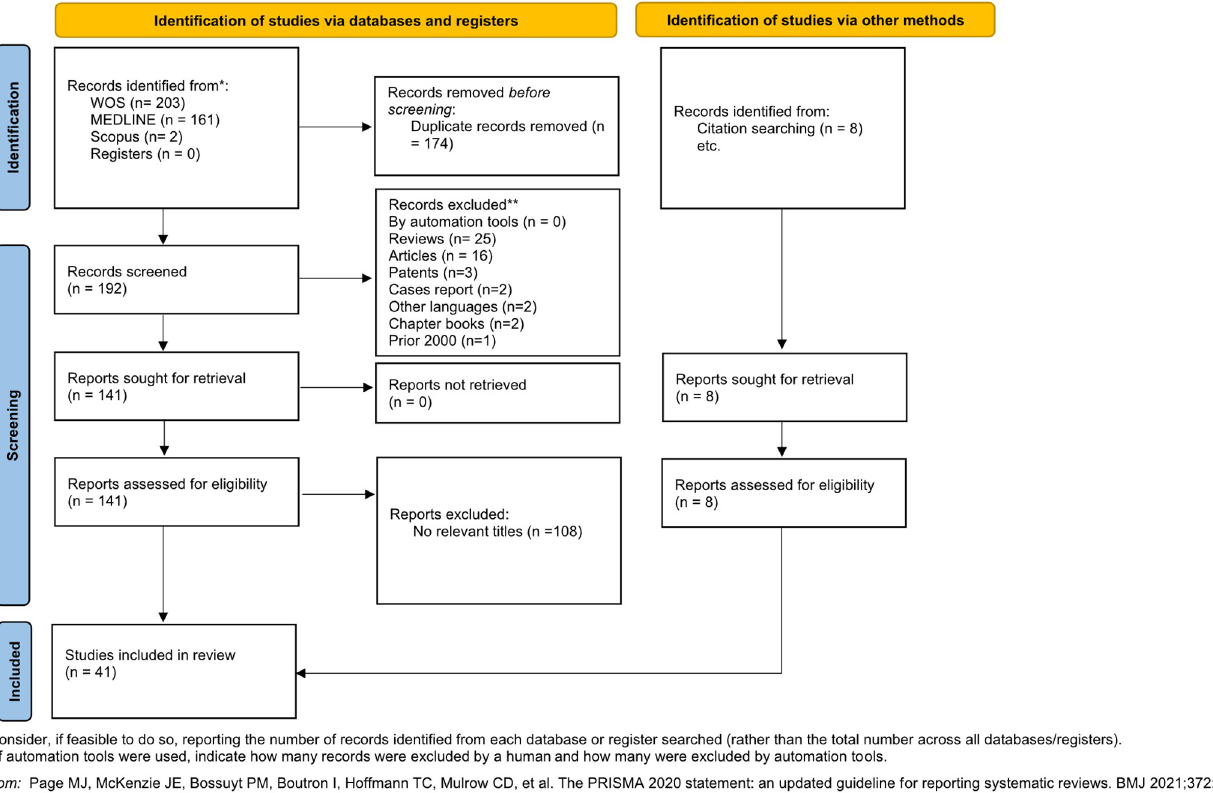
Fig 1. Flowchart of the systematic review